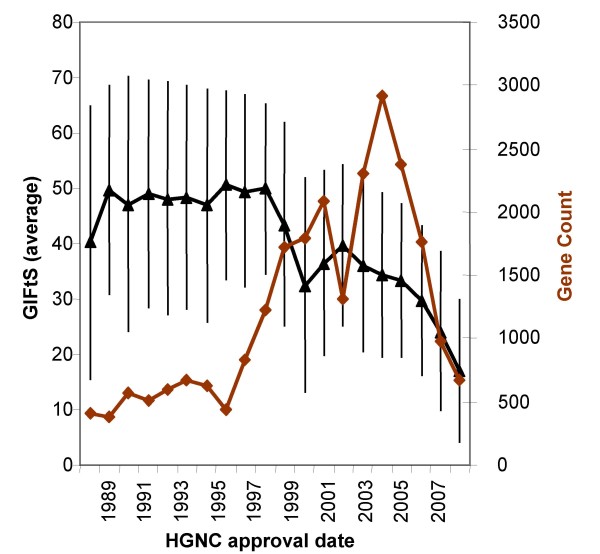
Time-dependence of annotation levels. Correlation between Human Gene Nomenclature Committee (HGNC) approval dates [39] and GIFtS average (bars represent standard deviation).